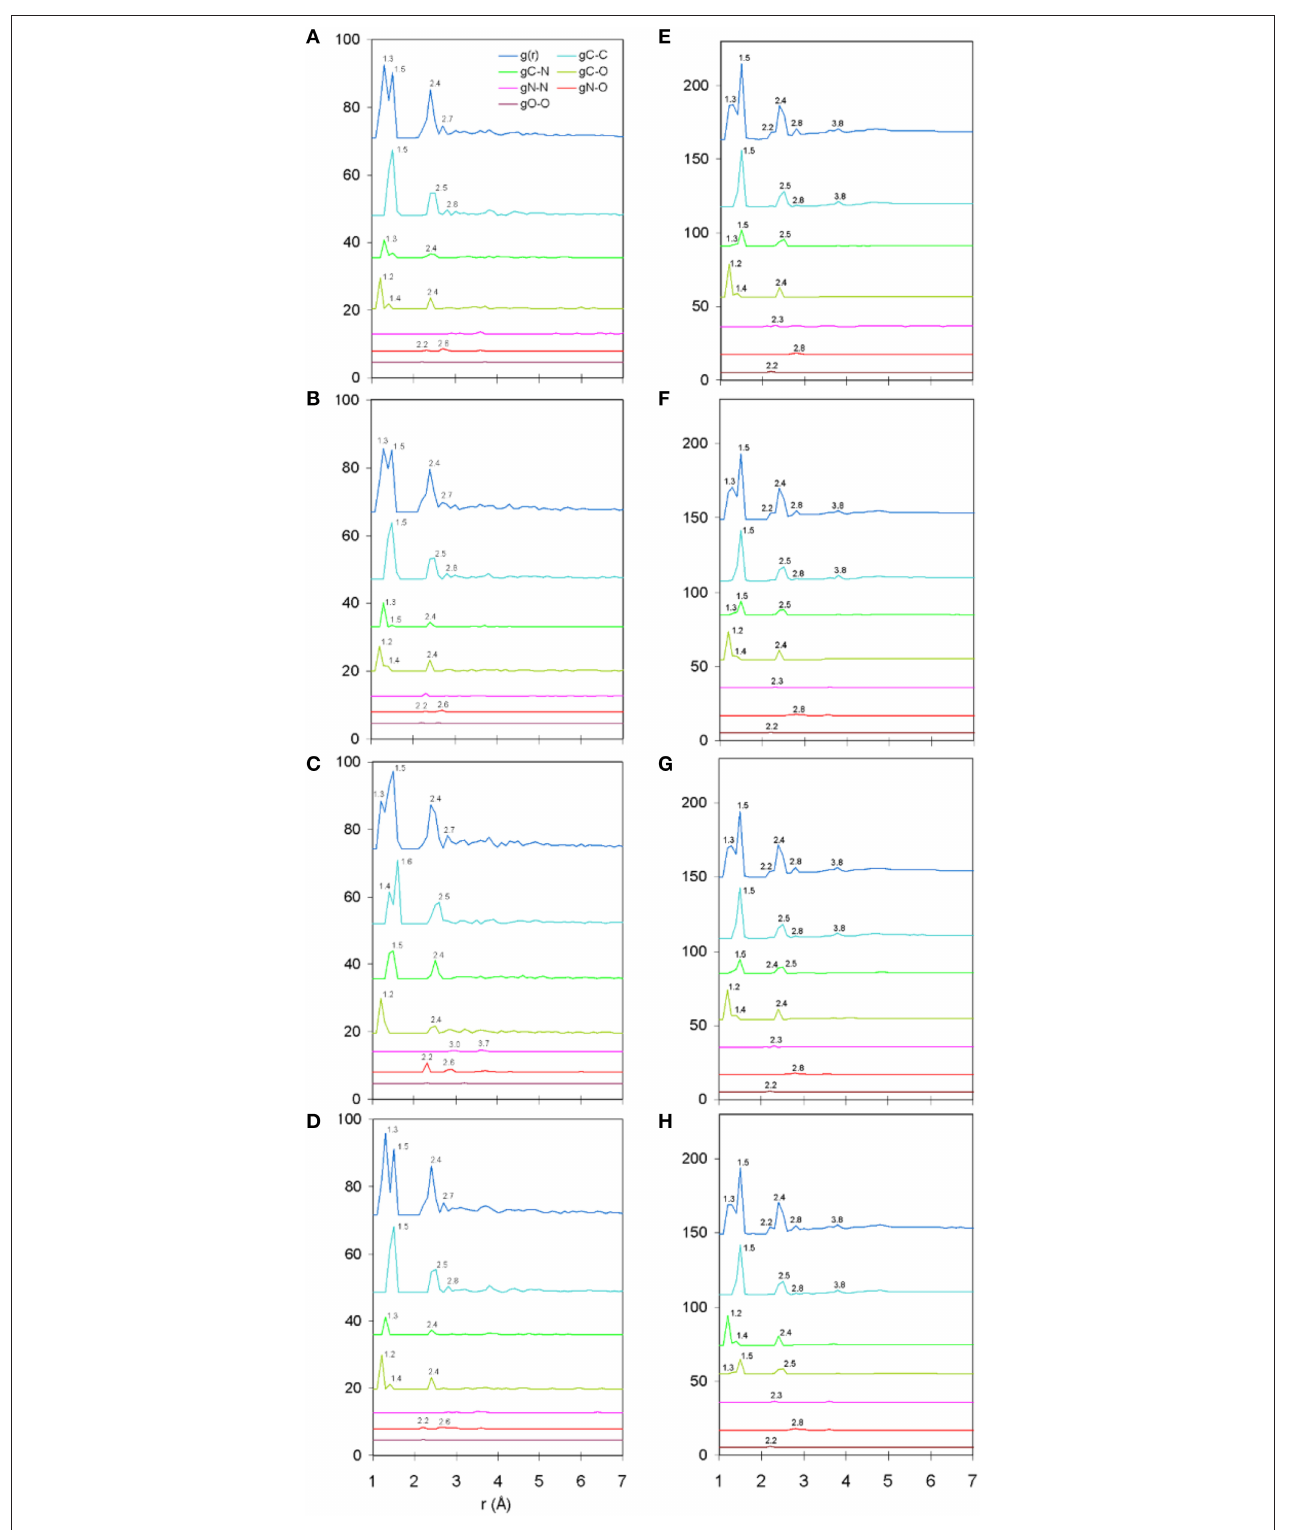
FIGURE 2 | Unprotonated structure total and partial PDF curves (symbolized as g(r) and gA-B, respectively where “A” and “B” are any of the C, N, or O species). From (A–D) : single peptides Tax, V7R, Y8A, and P6A, respectively. From (E–H) : entire pMHC-TCR complexes of the Tax, V7R, Y8A, and P6A peptides, respectively. All interatomic distances have been rounded up to the first decimal digit. Each of the partial curves has been normalized by the average number density of the peptide.